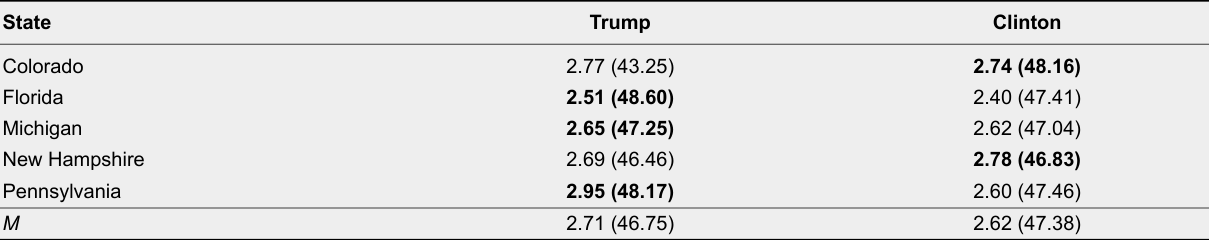
Ratios of Affiliative Responses per Minute Evoked by Each Candidate in Swing States